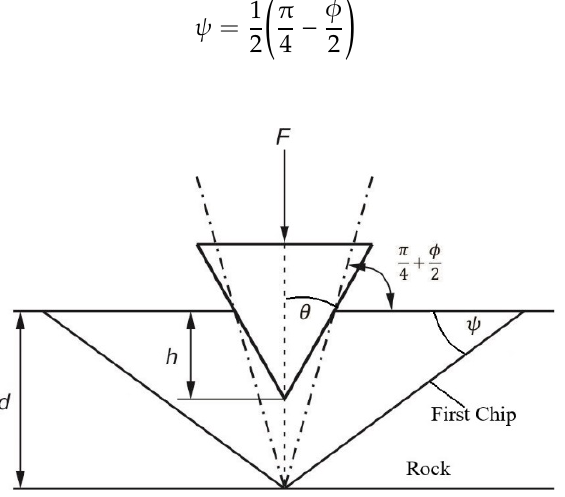
Figure 3. Formation of the first wedge under the influence of the action of a single tooth [42].